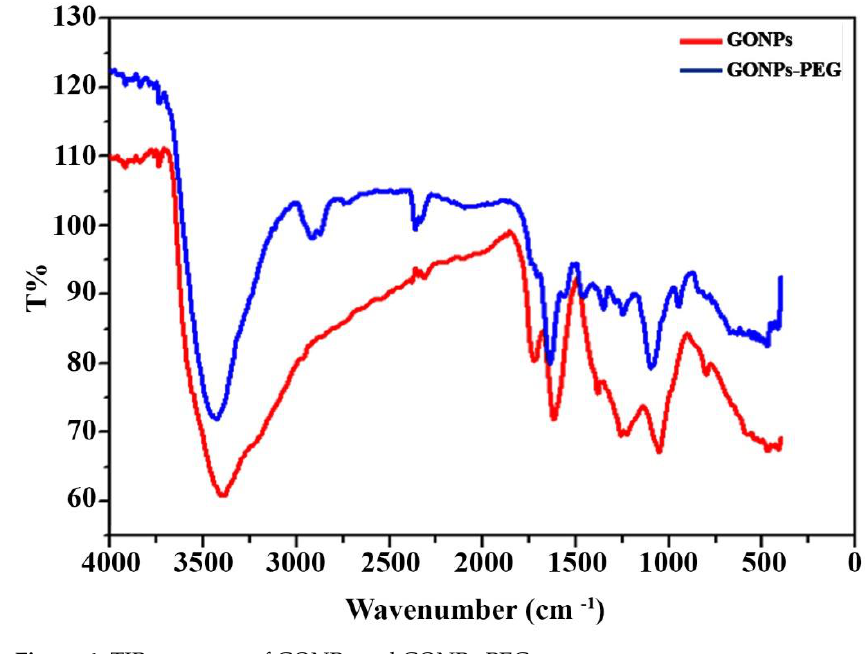
Figure 4. TIR spectrum of GONPs and GONPs-PEG.